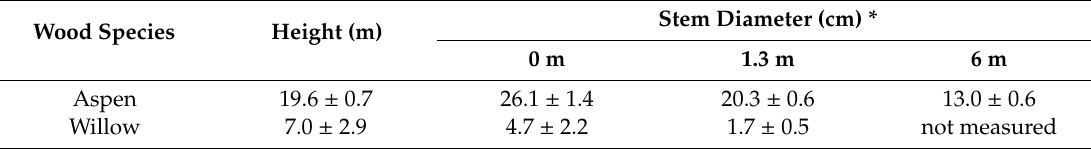
Table 1. Characteristics of the sample trees in Tuusula, Finland (mean ± standard deviation). Wood Species Height (m) Stem Diameter (cm) * 0 m 1.3 m 6 m Aspen 19.6 ± 0.7 26.1 ± 1.4 20.3 ± 0.6 13.0 ± 0.6 Willow 7.0 ± 2.9 4.7 ± 2.2 1.7 ± 0.5 not measured